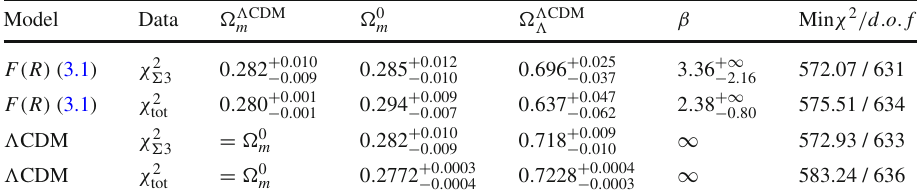
panels of Fig. 2. In order to compare these results with those obtained under the approximation (5.1), the curves of Fig. 1 are depicted as well, denoted by magenta lines for χ 2 (cid:17) = (cid:10) (cid:2) CDM / [ E ( 0 ) ] 2 are obtained. These values help and by thin black dash-dotted lines for χ 2 and (cid:10) 0 m m , β planeinthetop-right us todraw thecontour plots inthe (cid:10) 0 panels). m panel of Fig. 2. The black stars in Fig. 2 denote the minimum points The same panels and notations of Fig. 1 are used in Fig. 2, of the two-dimensional distributions χ 2 ((cid:10) (cid:2) CDM , β) in ((cid:10) 0 , β) . Their coordinates (the optimal values of param- χ 2 but the blue contours corresponds to χ 2 (cid:17) m m tot 3 Fig. 2 while the blue lines refer to the one-dimensional dis- eters) are tabulated in Table 3. In the same way, the minimum ((cid:10) (cid:2) CDM ) and χ 2 (β) in the bottom are shown as the blue tributions χ 2 (cid:17) points for χ 2 (cid:17) (cid:17) 3 min m 3 min 3